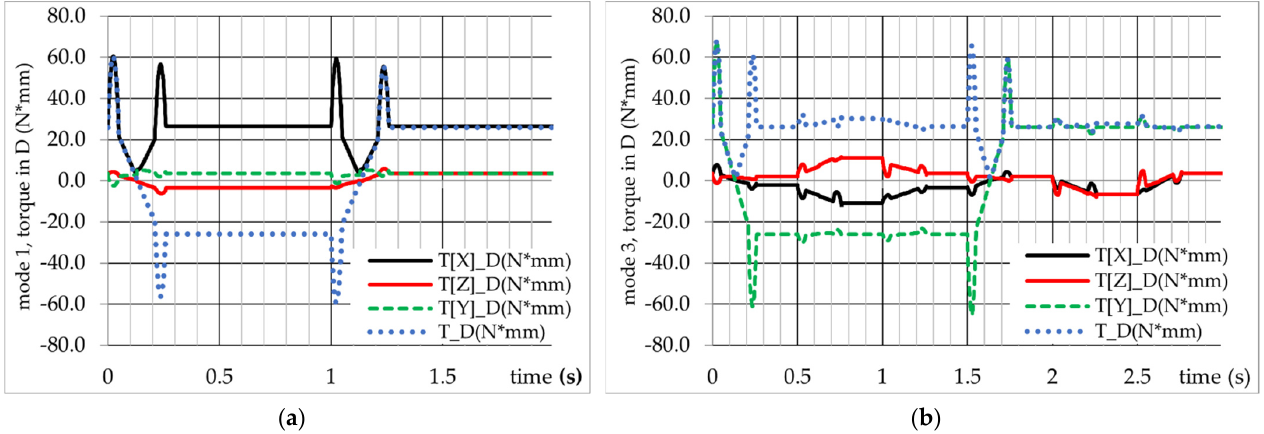
Figure 7. Computed results in terms of torques of D of the first leg: (a) in Mode 1; (b) in Mode 3.